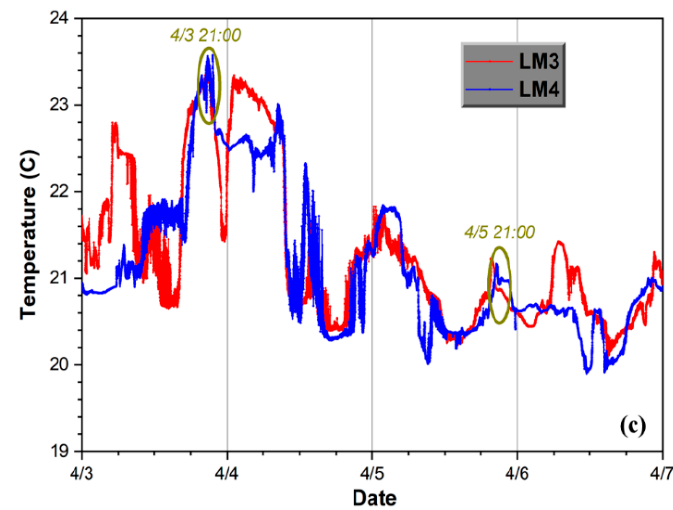
Figure 13. Model-mooring comparison. ( a ) Model temperature flux (°C m/s) at 21:00 UTC on 4/3; ( b ) Model temperature flux (°C m/s) at 21:00 UTC on 4/5; ( c ) Surface temperature (°C) at moorings LM3 and LM4 (times corresponding to model results in panels a and b are indicated).